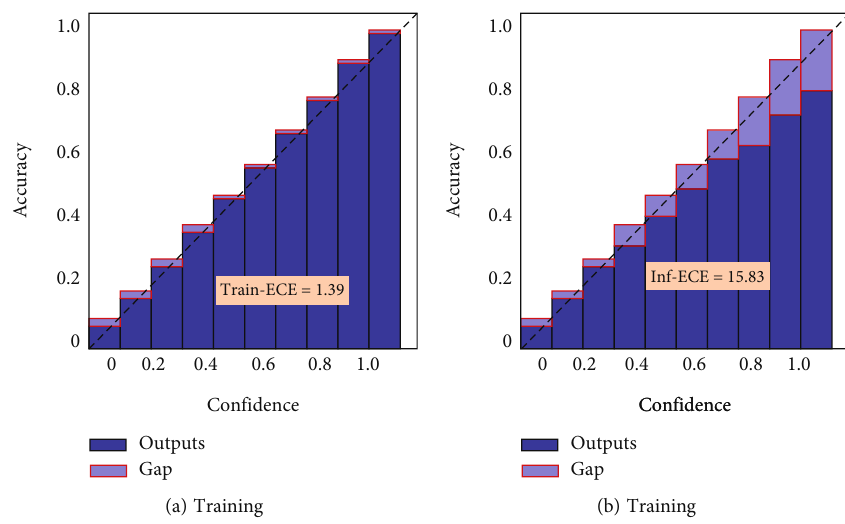
Figure 3: Japanese translation calibration feature distribution.